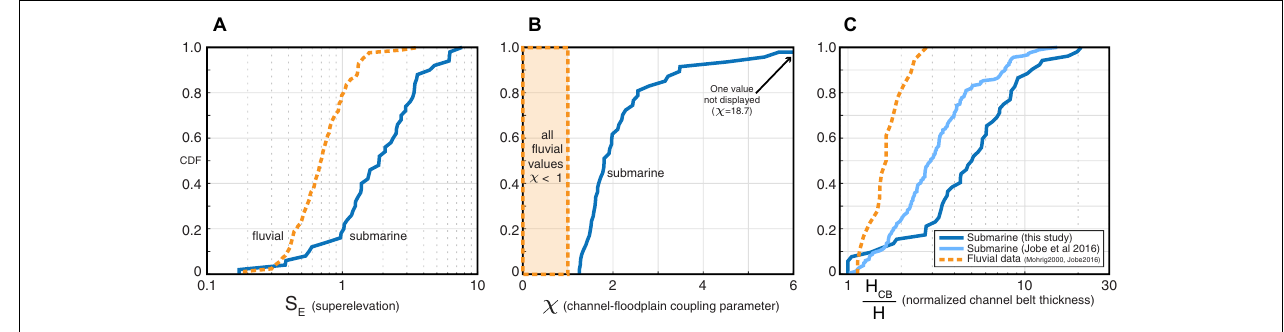
FIGURE 5 | Comparisons of fluvial and submarine channel-belt parameters superelevation (A) , χ coupling parameter (B) , and normalized channel-belt thickness (C) . In all cases, submarine channels show evidence for more aggradation and superelevation than rivers. These metrics suggest that avulsion criteria are very different for submarine and fluvial environments.